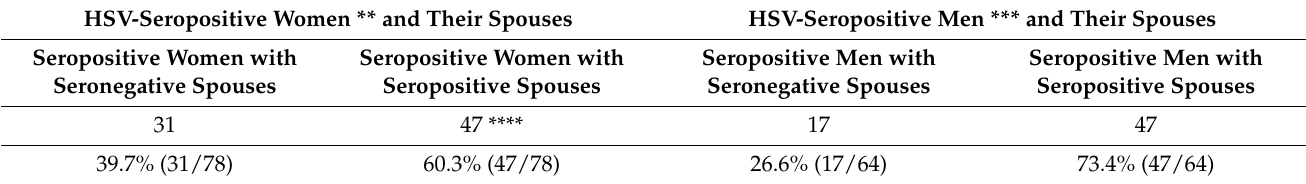
Table 2. Herpes simplex virus (HSV *) seropositivity among the